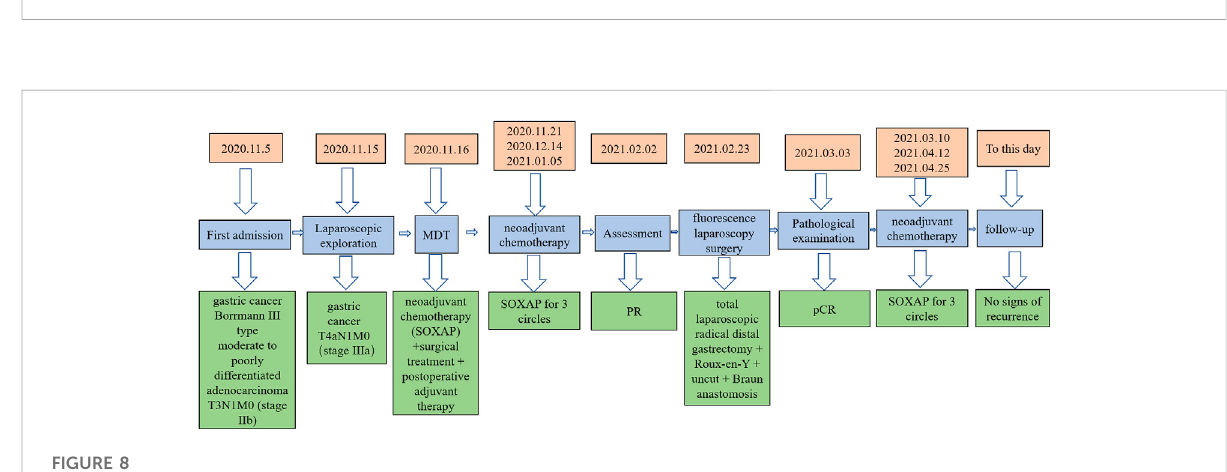
FIGURE 7 Postoperative upper gastrointestinal angiography and CT coronal plane. (A,B) showed that the reconstructed digestive tract is unobstructed, and the anastomosis is normal. (C) showed no obvious signs of recurrence and metastasis after surgery and another three cycles of adjuvant treatment.